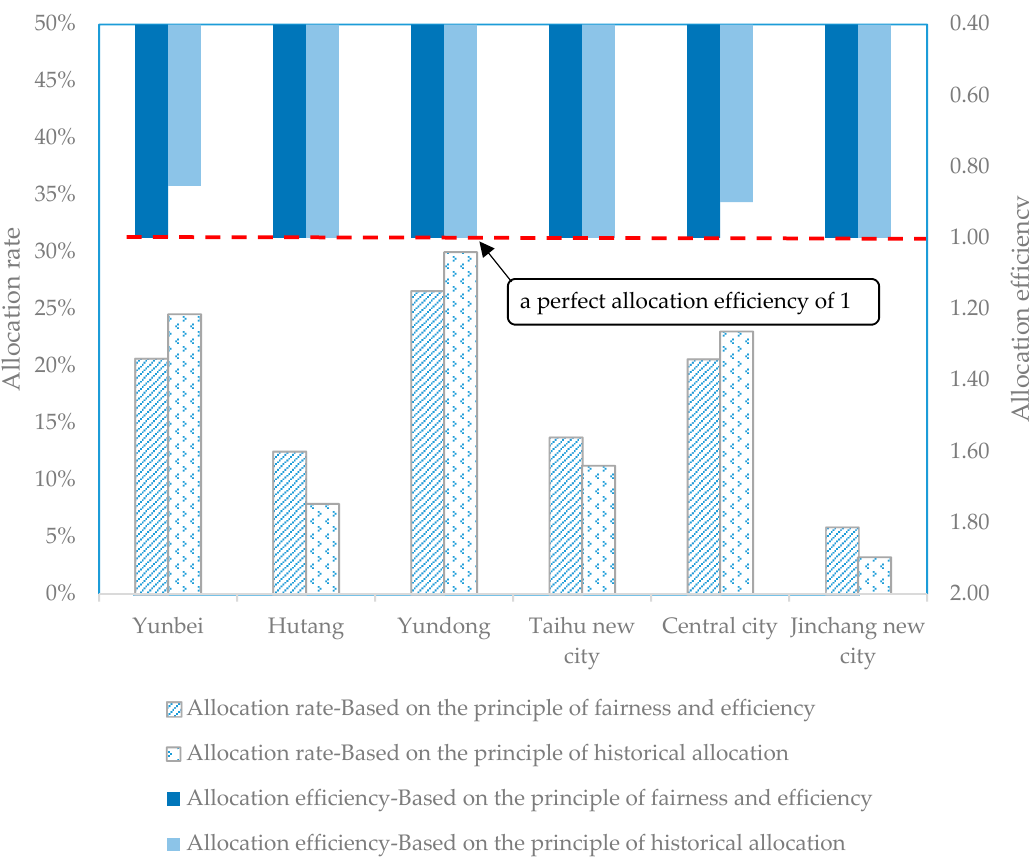
Figure 4. Allocation rates and efficiencies under different allocation principles.